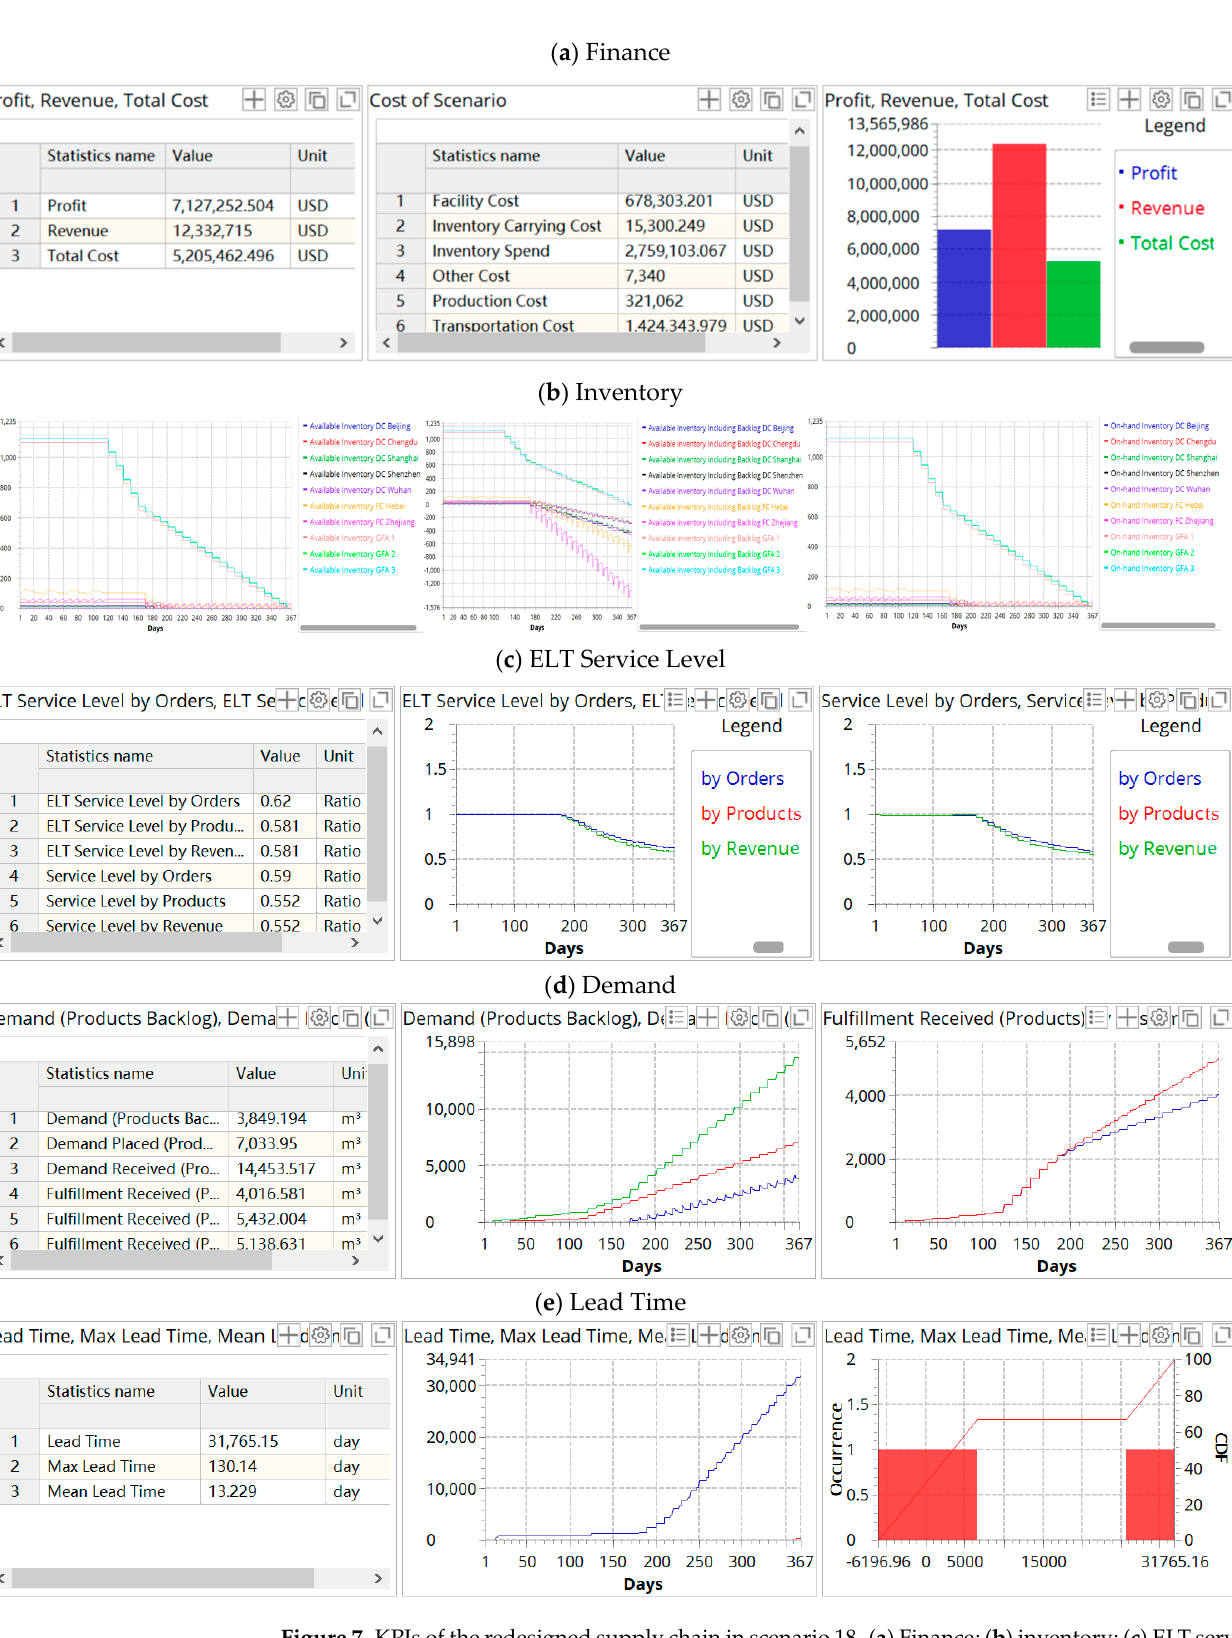
Figure 7. KPIs of the redesigned supply chain in scenario 18. ( a ) Finance; ( b ) inventory; ( c ) ELT service level; ( d ) demand, where the titles are Demand (Products Backlog), Demand Placed (Products) by Customer ( left ), Demand Received (Products), Fulfillment Received (Products On—time) ( middle ), Fulfillment Received (Products), Fulfillment Received (Products) by Customer ( right ); ( e ) lead time. Table 7. Performance comparison.